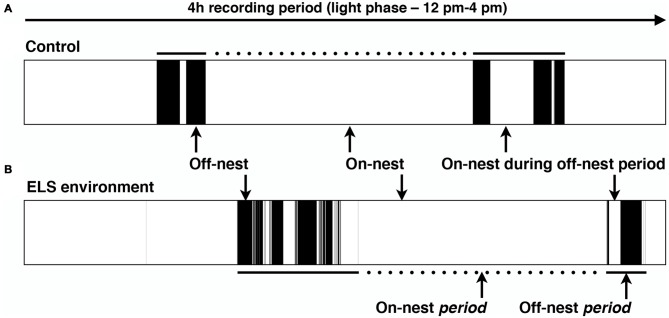
Representative schematic of the dam’s location in relation to the nest in the home cage. Black color indicates that the dam is off-nest, while on-nest time is represented in white. Complete on-nest periods (dotted lines) are alternated with off-nest periods (solid lines) by dams in both the control and ELS environment. (A) Typical pattern of on/off-nest behavior by a dam in a control and (B) ELS environment in a 4-h recording period during the afternoon of the light phase. An ELS environment induces an increase in the number of nest entries by the dam, but only during off-nest periods.